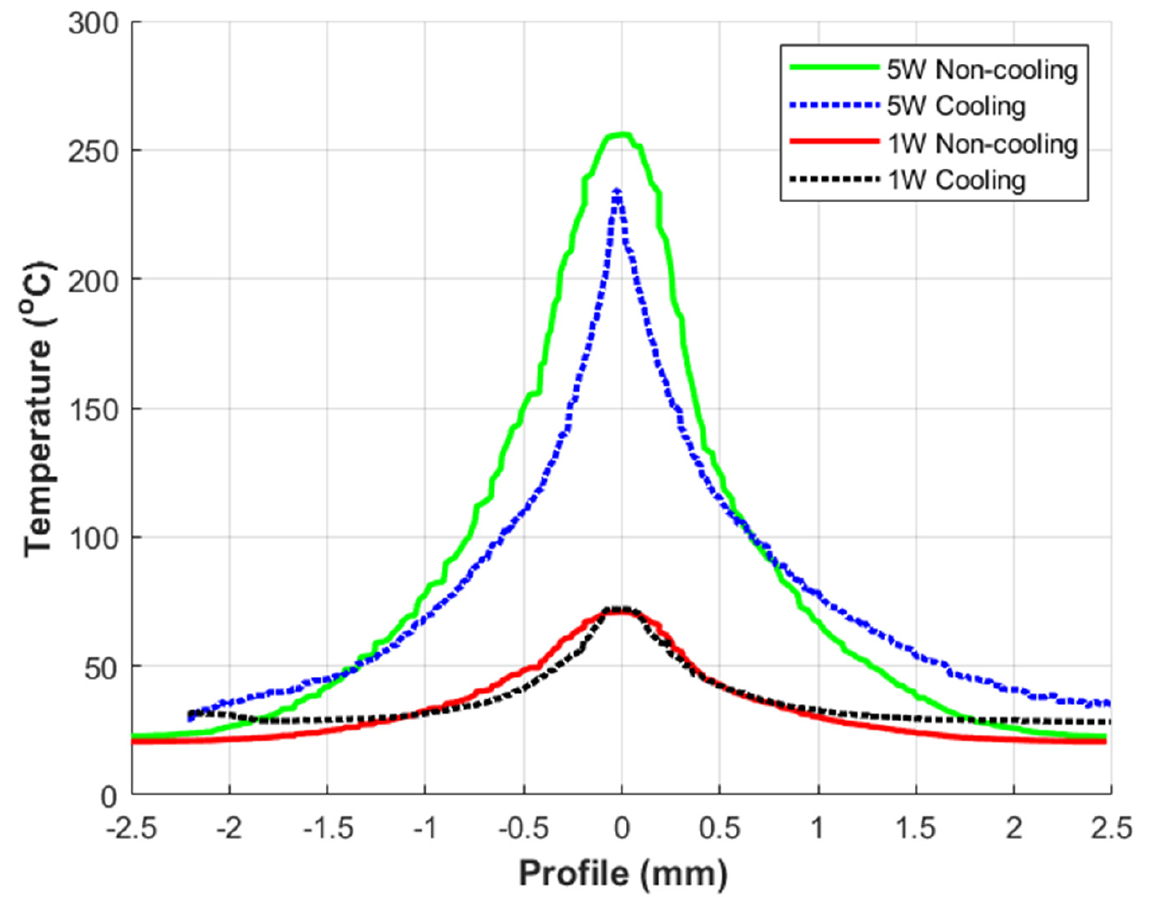
Figure 6. The temperature distribution of unit cells on the sapphire wafer with and without cooling.